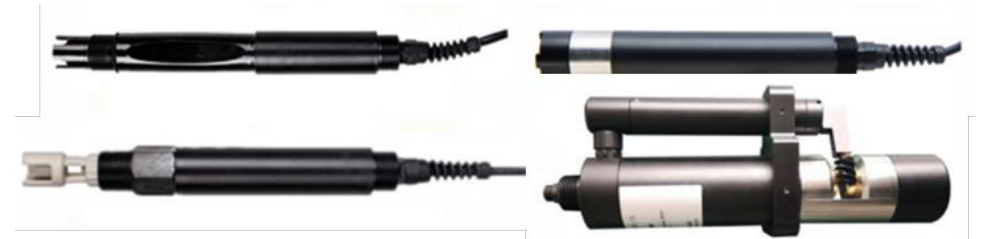
Figure 14. pH/OD/EC/COD sensors.